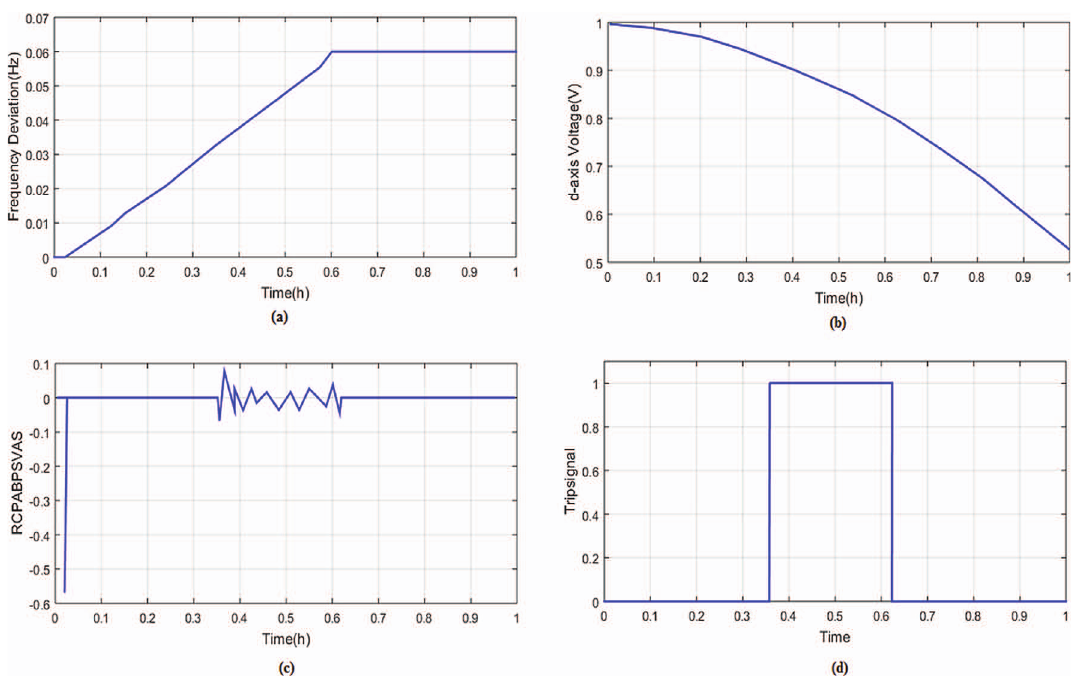
Fig. 9. System performance under balanced loading conditions, (a) frequency deviation versus time, (b) d -axis voltage versus time, (c) RCPABPSVAS versus time, and (d) trip signal versus time.